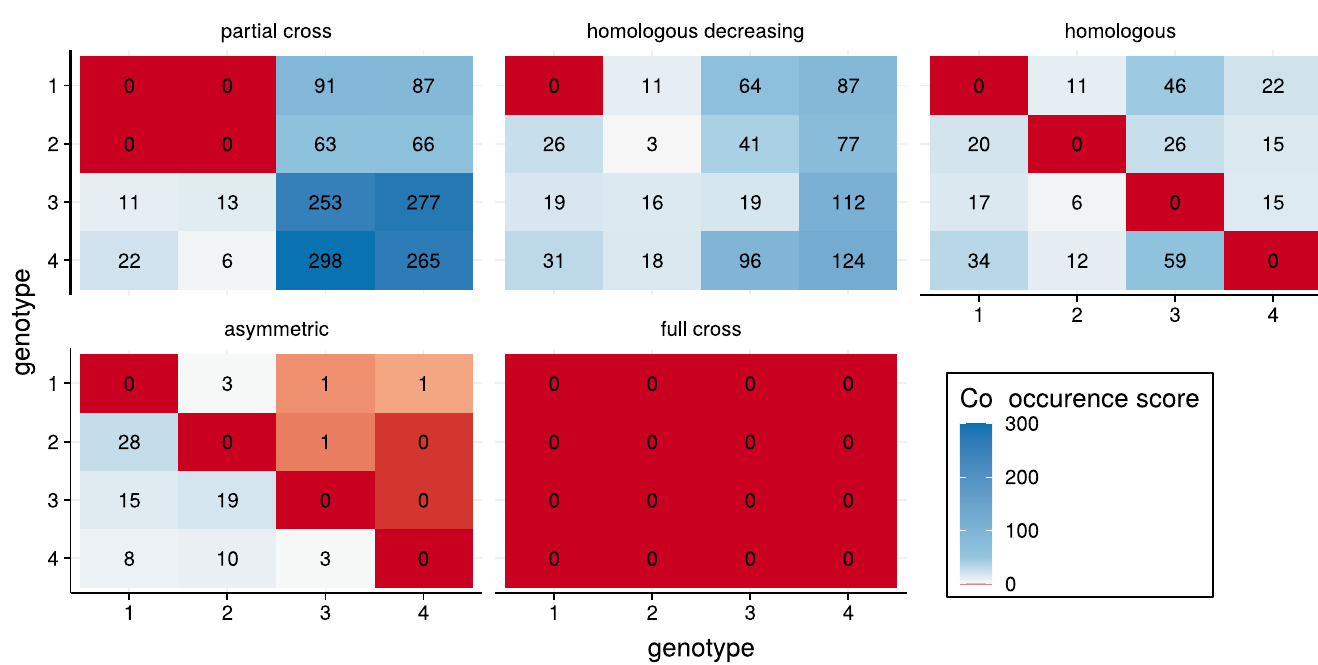
Fig 6. Co-occurrence score from infection barcode outputs of simulations with various assumptions on immunological interference. The underlying cross- immunity matrices are shown in the Materials and methods. The combinations with 100% cross-immunity correspond to the red cells with 0 co-occurrence score.